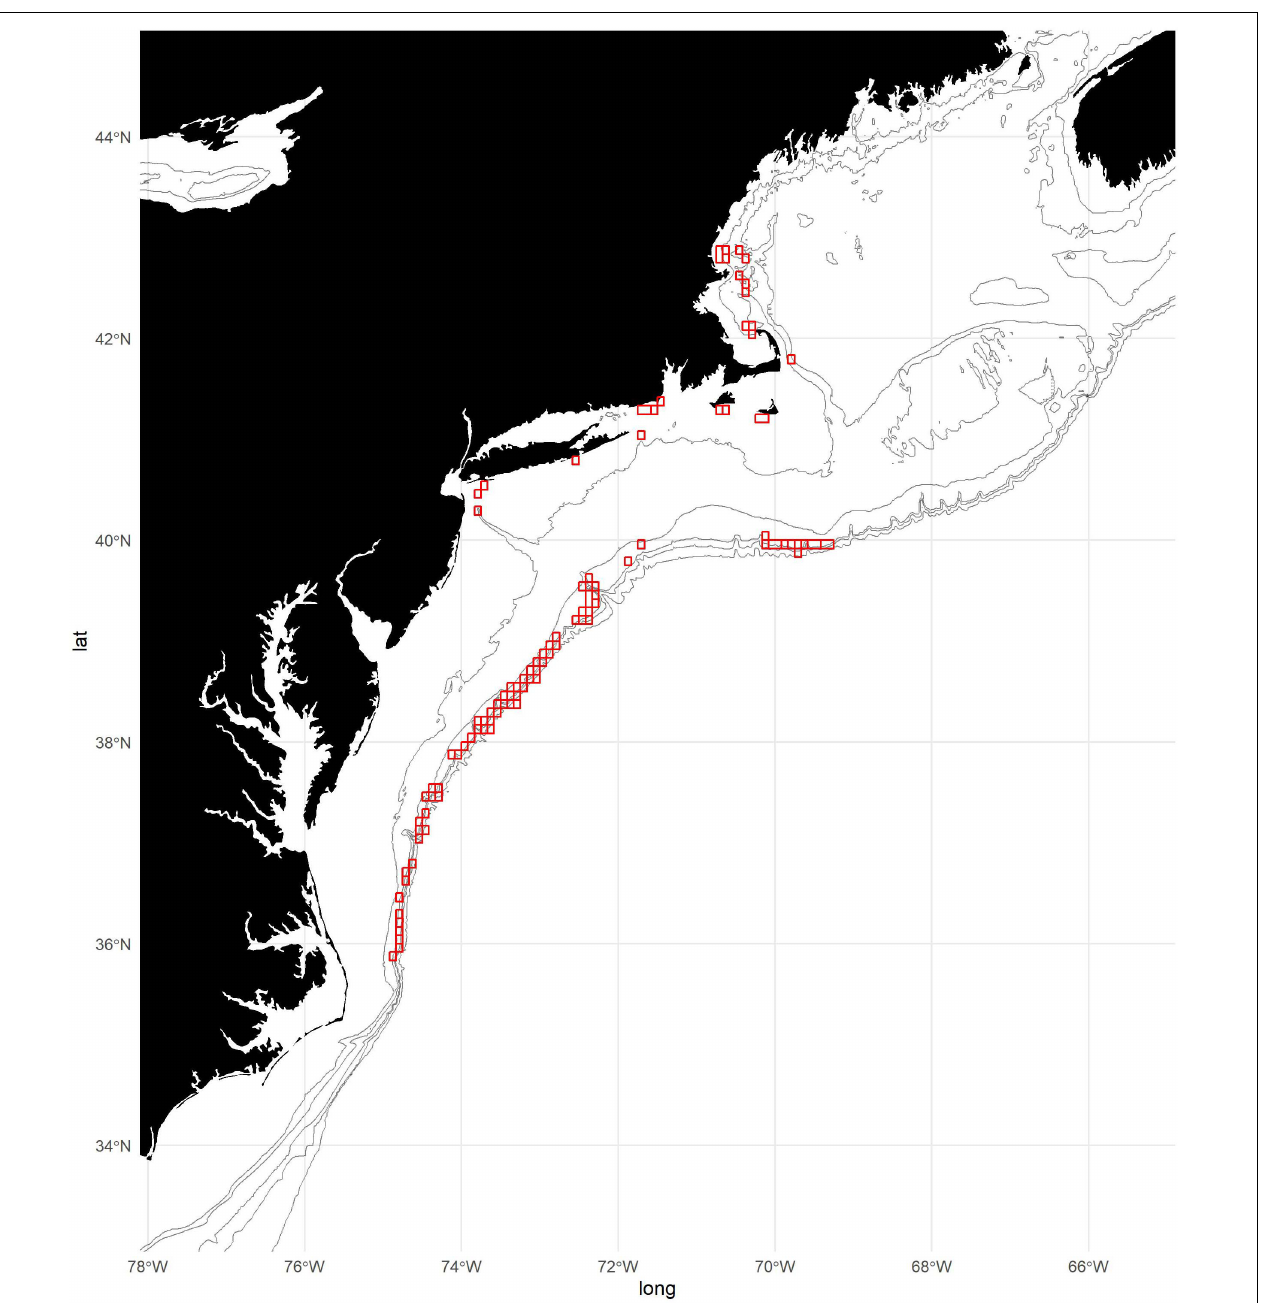
FIGURE 1 | Map of study area with 50, 100, 300, 500, and 1,000 m isobaths. Locations of fishing effort aggregated to 5-min squares are shown in red. Note that some areas of fishing effort have been excluded from the figure to maintain